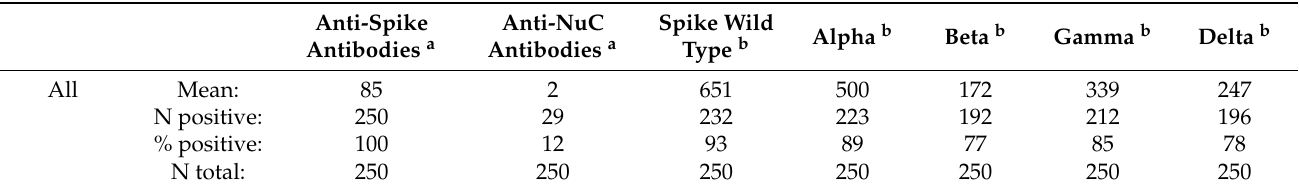
Table 3. Presence of SARS-CoV-2 antibodies and neutralizing activity by variant in a random sub- sample of seropositive participants at the third serosurvey in June–July 2021 (N = 250).